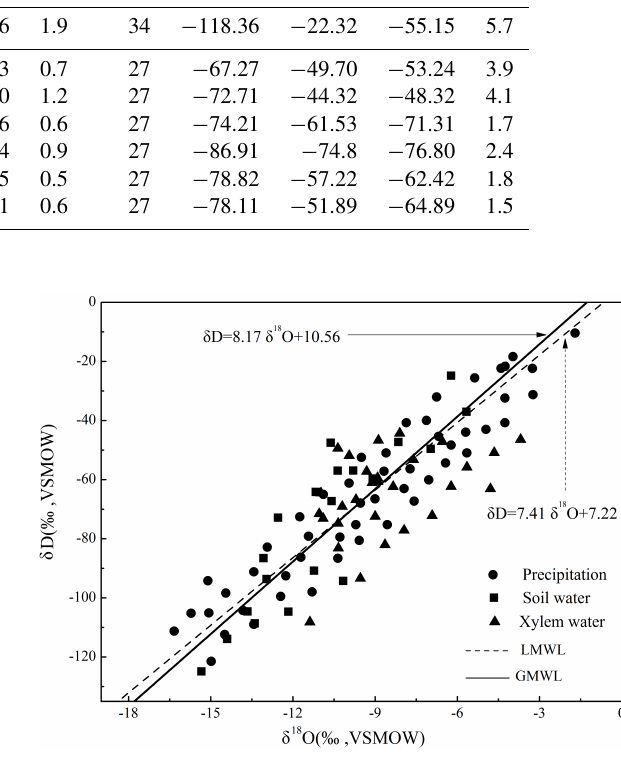
Figure 2. Plot of δ D vs. δ 18 O for the various samples in the study